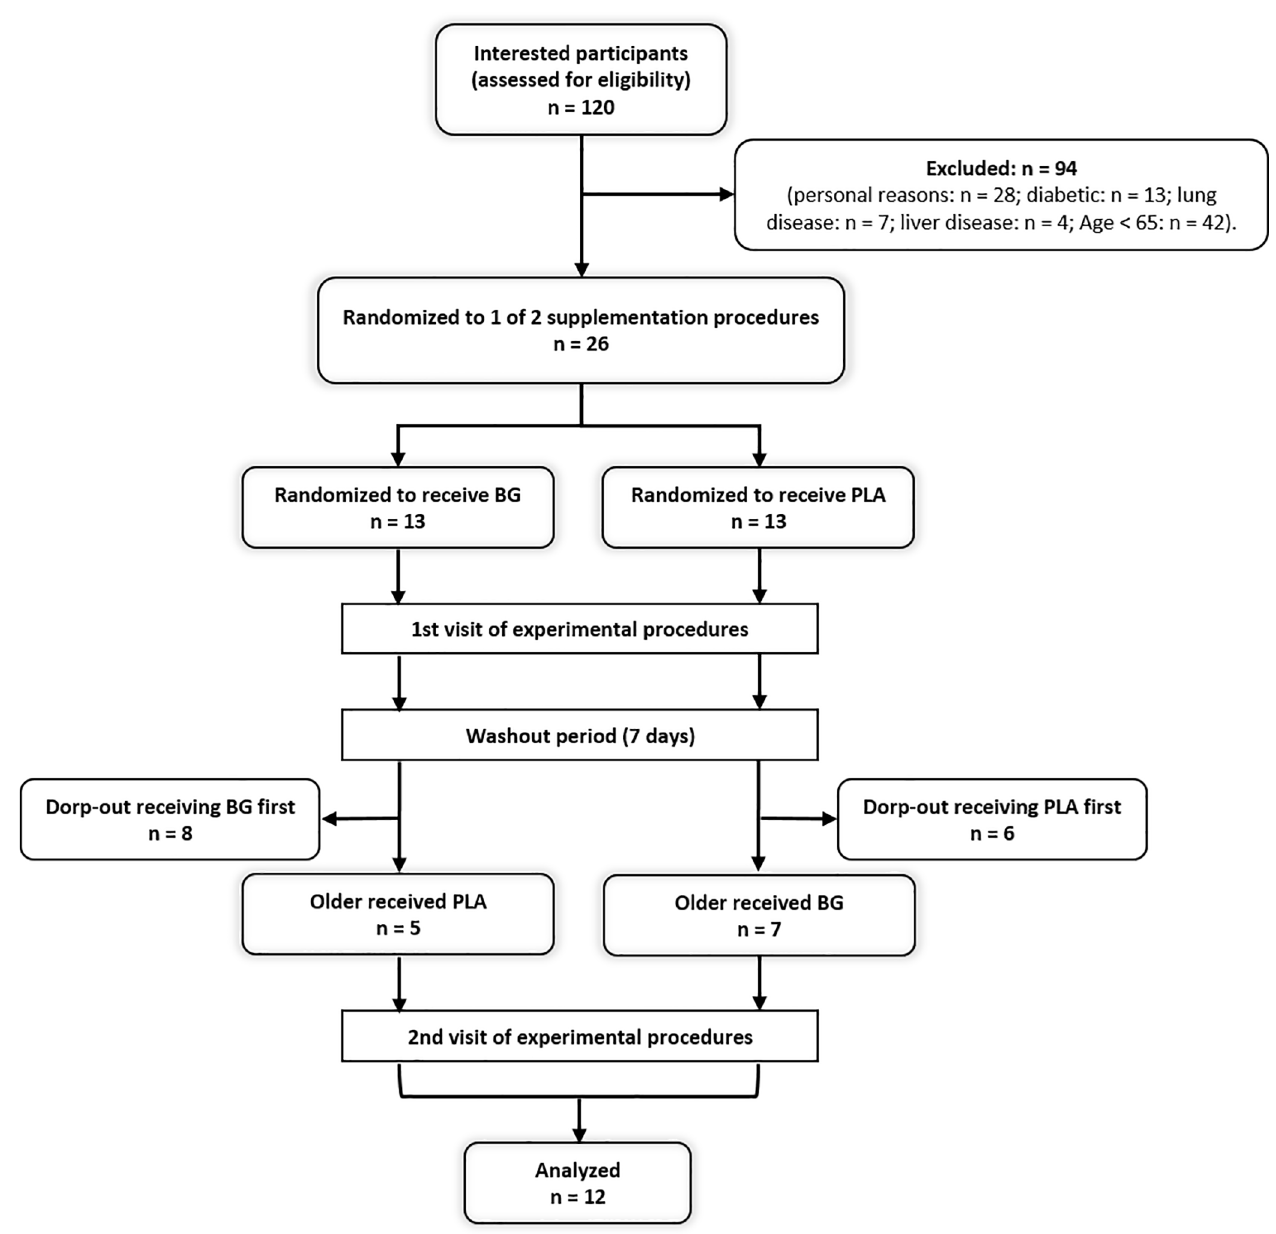
Fig 1. Flow diagram of the progress through the phases of the randomized, crossoverand placebo-controlled study. https://doi.org/10.1371/journal.pone.0188893.g001 three occasions, with at least 1-week interval between visits. The first visit was used to explain the experimental procedures and collect clinical and anthropometric data, as well as to ensure familiarity with the handgrip exercise protocol. In the second and third visits urine samples were drawn at baseline (T0) after a 10-min period of quiet rest. Thereafter, subjects were ran- domly divided into either a beetroot-based nutritional gel (BG) or a control nitrate-depleted gel (PLA). NIRS measurements in response to the handgrip exercise protocol began approxi- mately 150 min after the nutritional intervention (T150) and lasted for approximately 10 min. Urine samples were drawn again at T90, T150 and T180 after nutritional intervention (Fig 2).